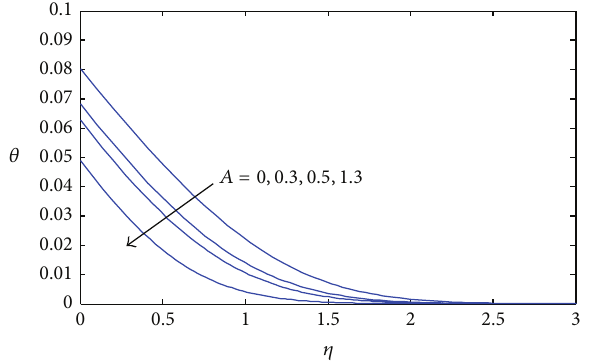
Figure 7: b = 0.1, 𝑓 𝑤 = 0.1 , Pr = 6.2 , 𝑀 = 0.5 , 𝑛 = 2 , and 𝜙 = 0.1